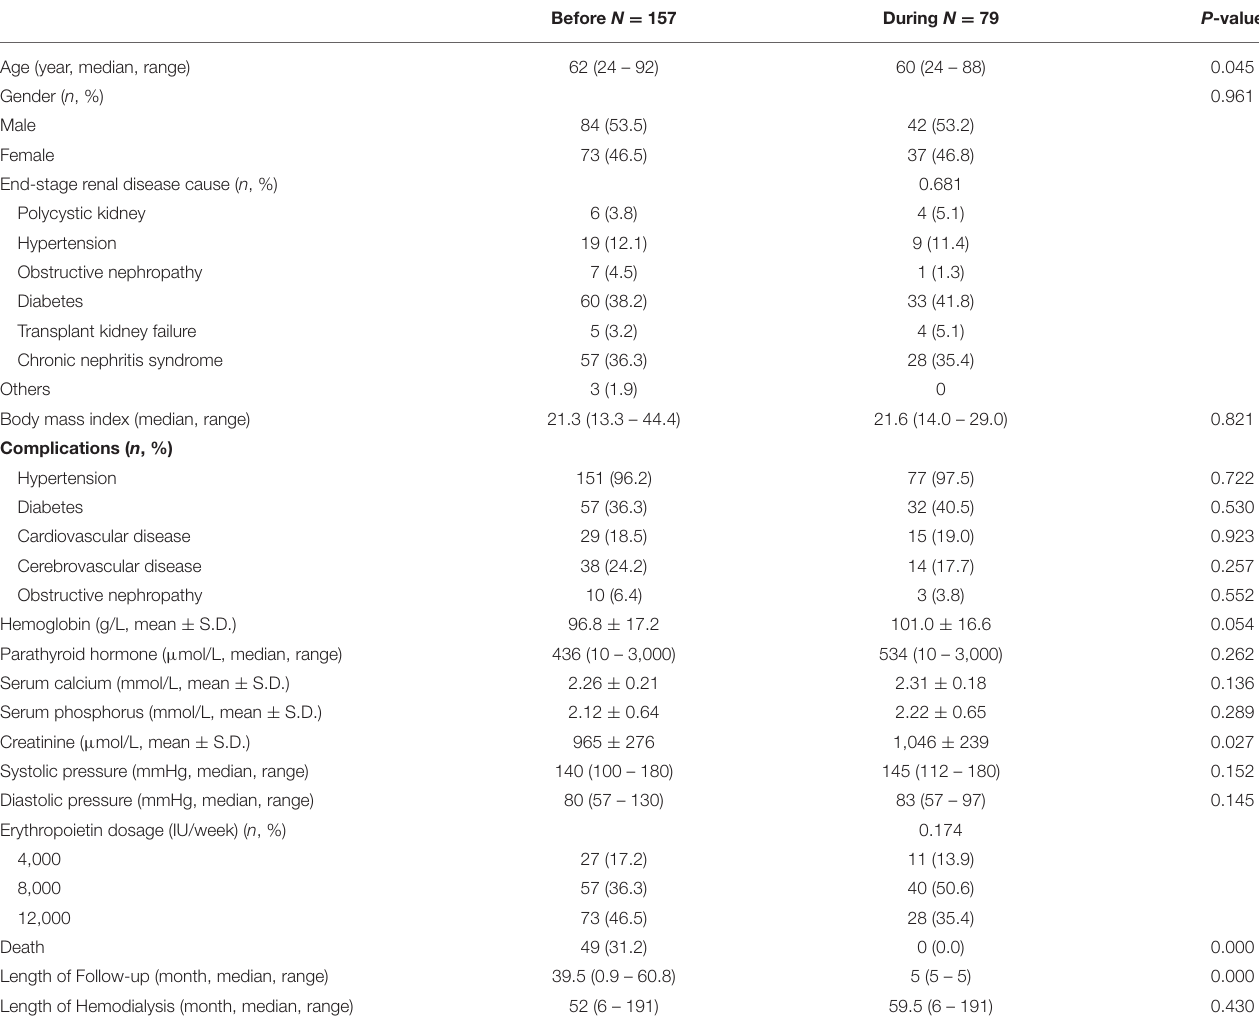
TABLE 1 | Hemodialysis patient characteristics before and during mitigative confrontation of the COVID-19 pandemic. Before N = 157 During N = 79 P -value Age (year, median,